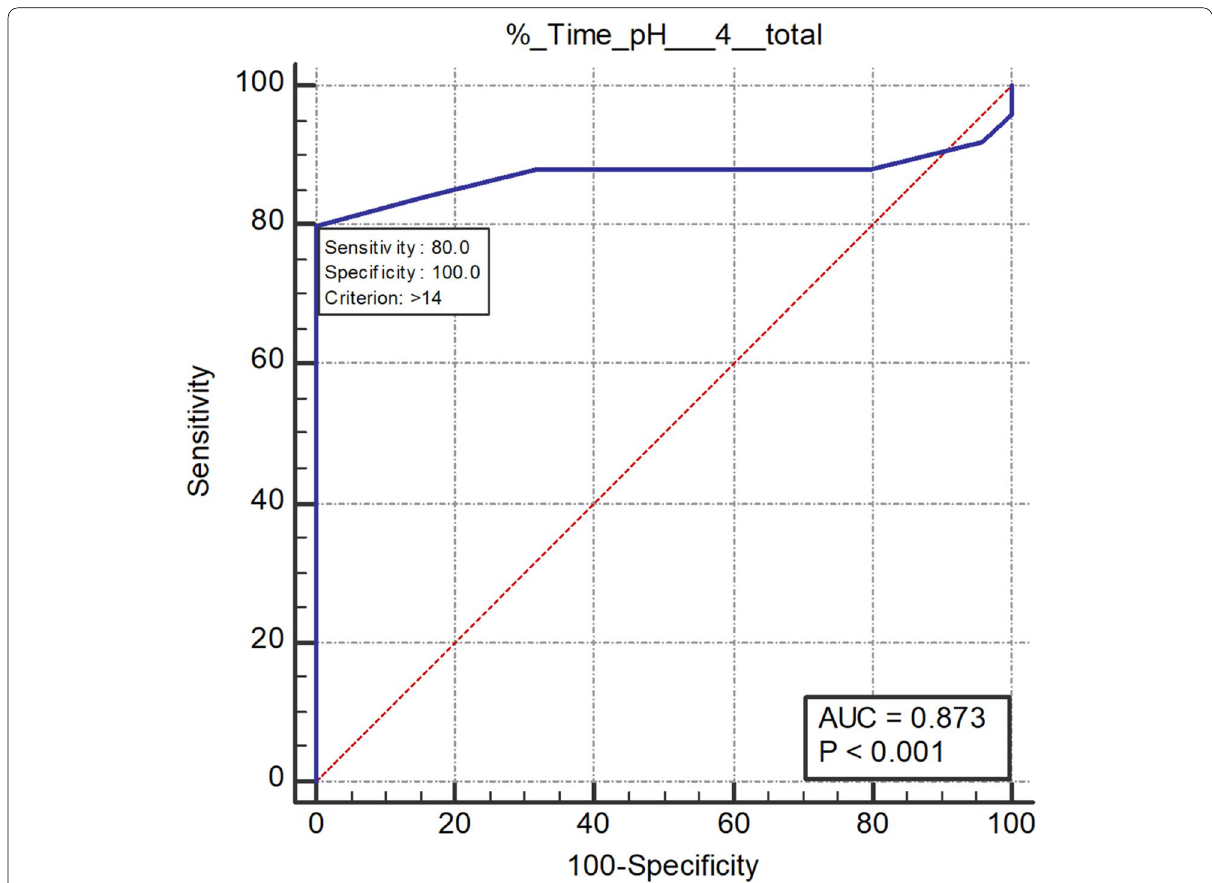
Fig. 4 ROC curve of pH-metry (% Time pH < 4)